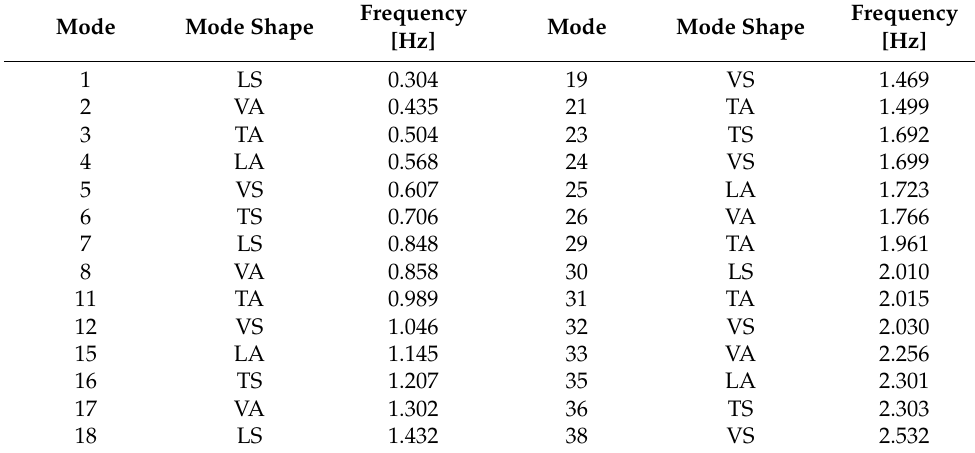
Table 7. Modal parameters of the footbridge obtained through FE